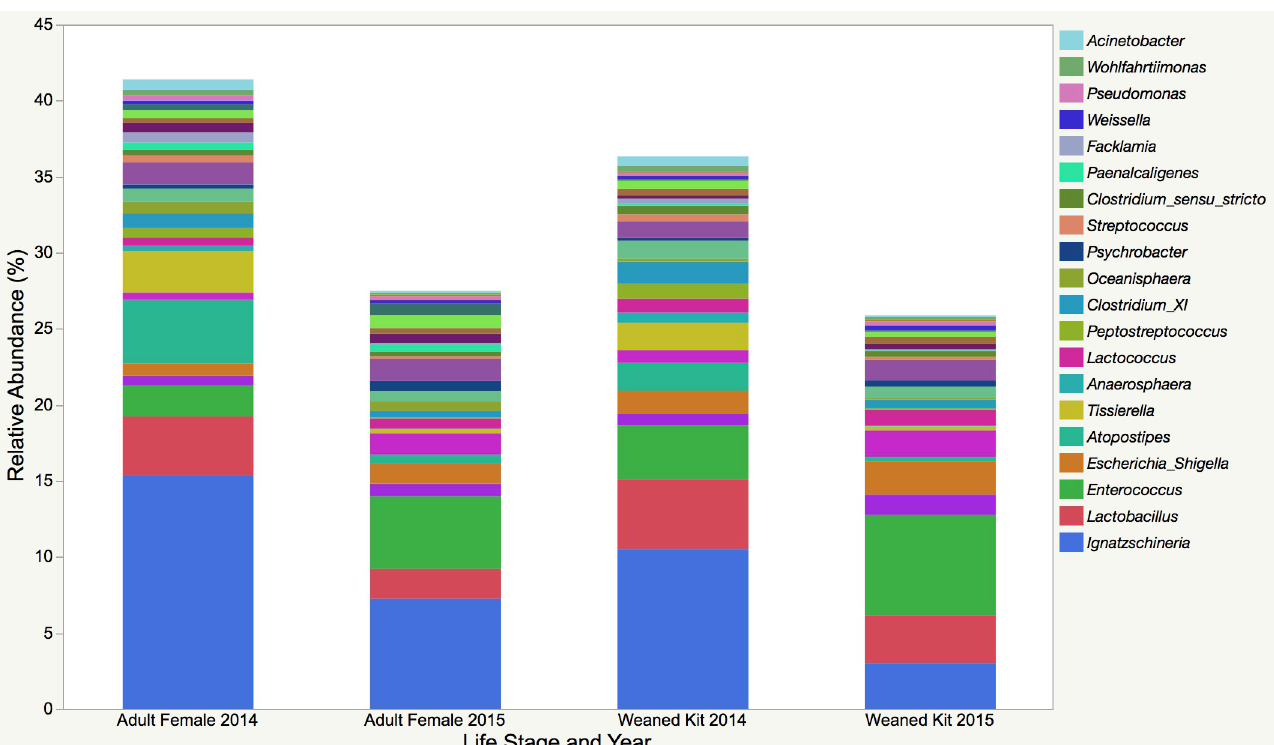
Fig 1. Relative abundance of the 20 most predominant bacterial genera present in the feces of commercial mink (n = 366). Samples were obtained from 43, 46, and 39 farms in 2014, 2015, and 2016, respectively.